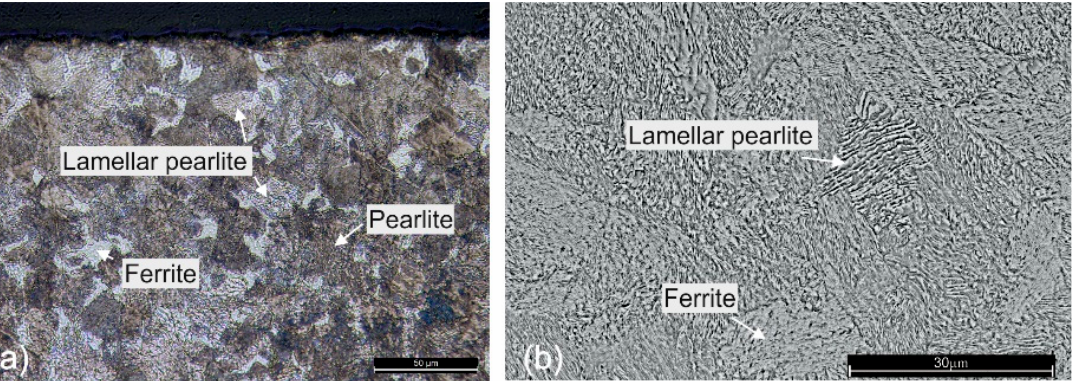
Figure 7. Analyses of the C45 base material, ( a ) optical microscopy and ( b ) SEM analyses highlighting the ferrite pearlite structure.